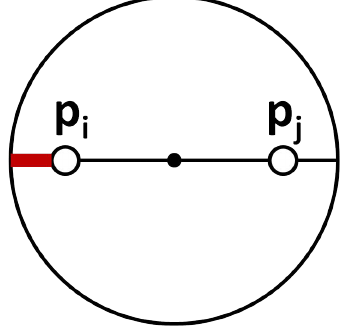
Figure 2. Motion restrictions for linked